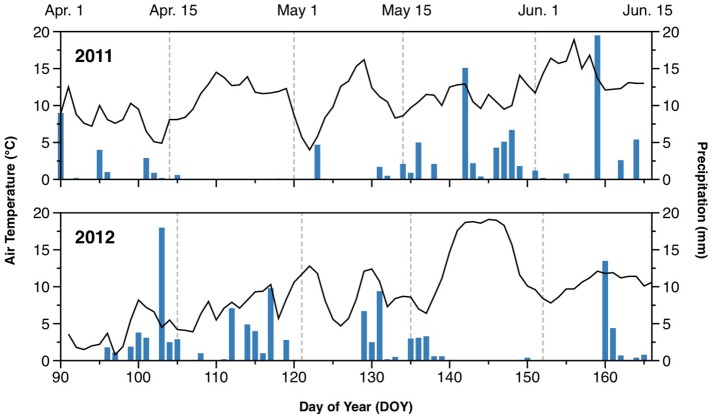
Air temperature (lines) and daily rainfall (bars) during the monitored periods in 2011 and 2012.